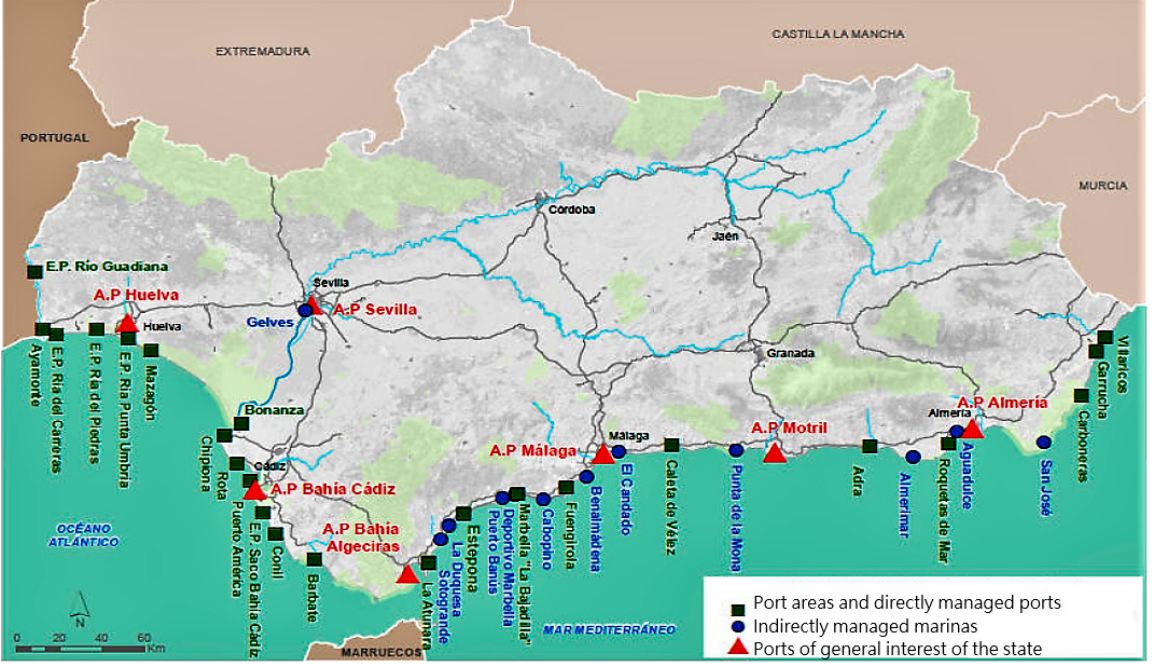
Figure 3. Port systems in Andalusia 2020. Source: Regional Ministry of Development, Infrastructures and Territorial Planning. Public Ports Agency of Andalusia.